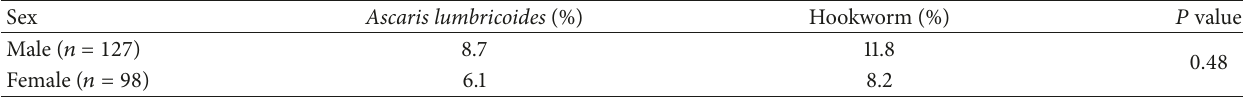
Table 2: Prevalence of intestinal helminths species by sex of